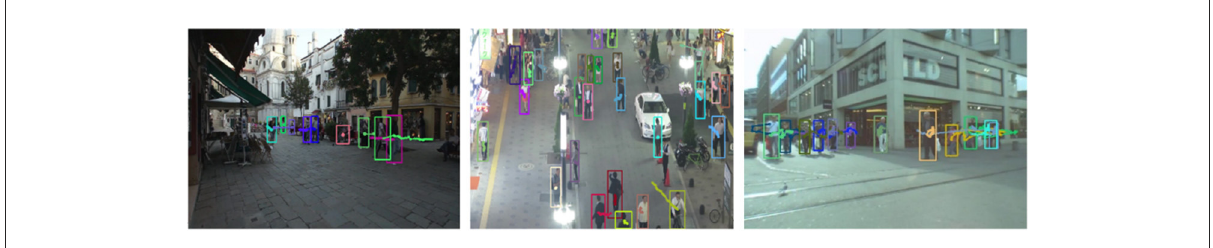
FIGURE11 Operation effect of the tracking algorithm MOT16 in this paper.